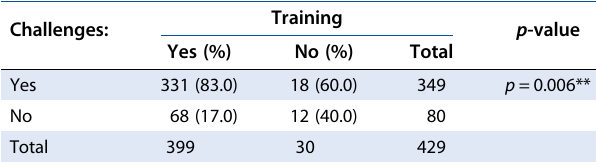
Table 6: Work challenges vs.